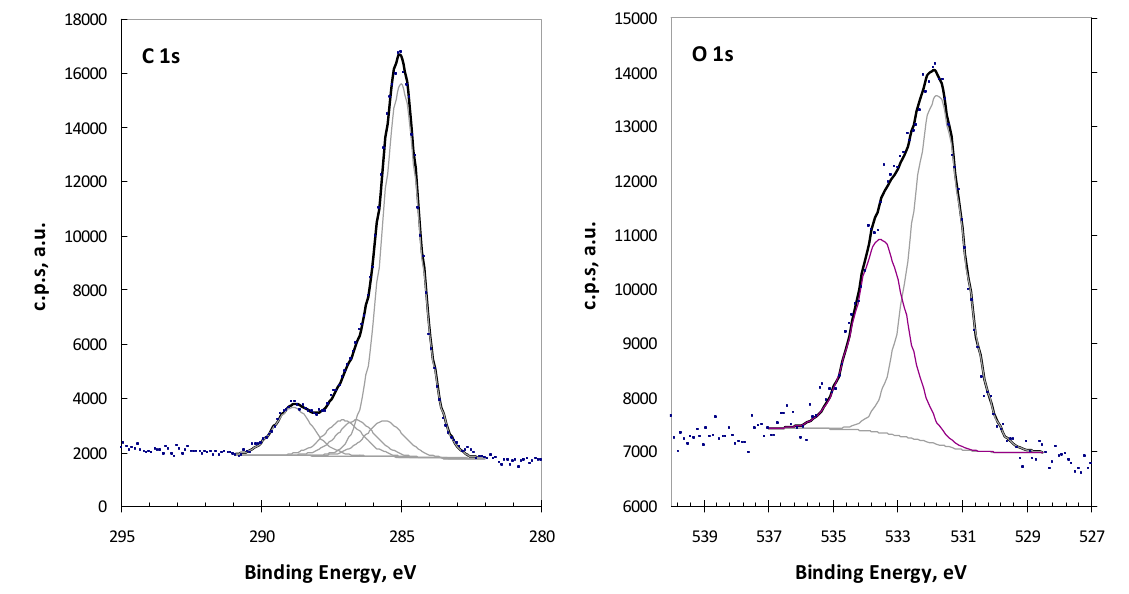
Figure 2. XPS regions Ag 3d, N 1s, C 1s and O 1s for complex 1 .